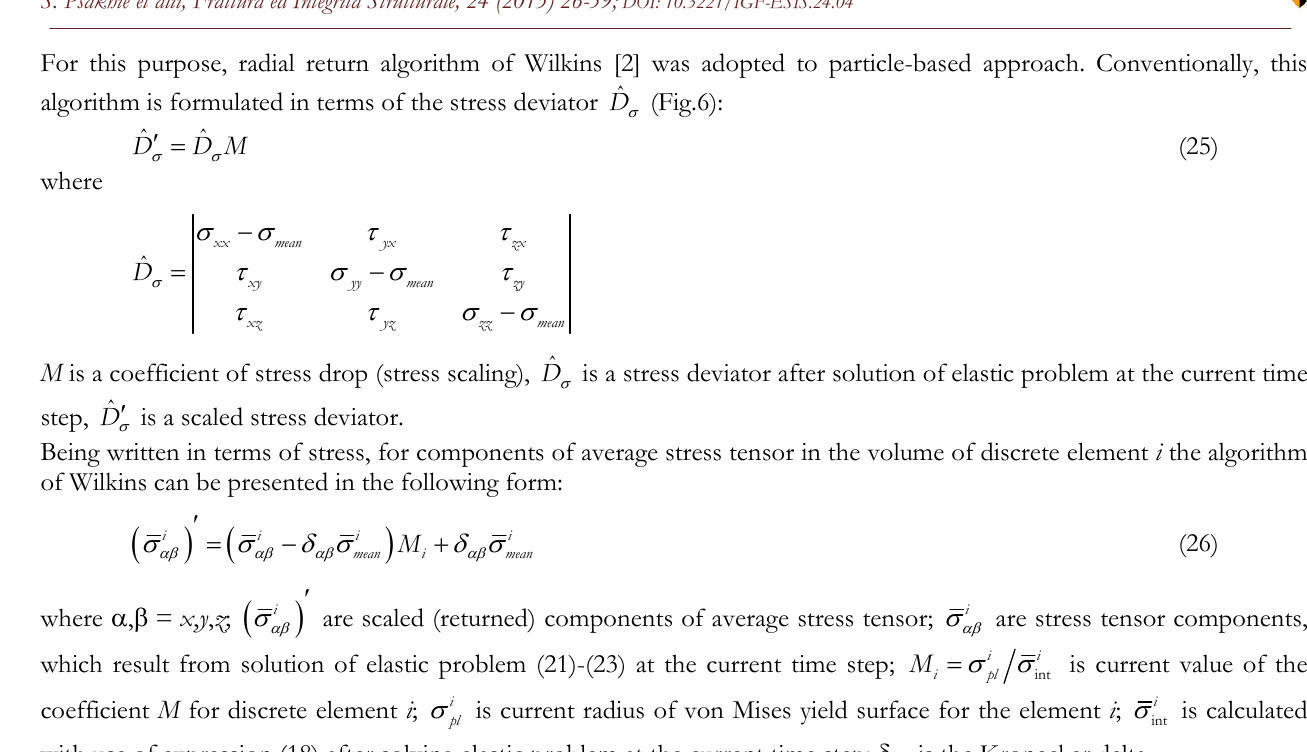
Figure 6: Schematic representation of functioning of radial return algorithm of Wilkins. Here  solution at the current time step, 